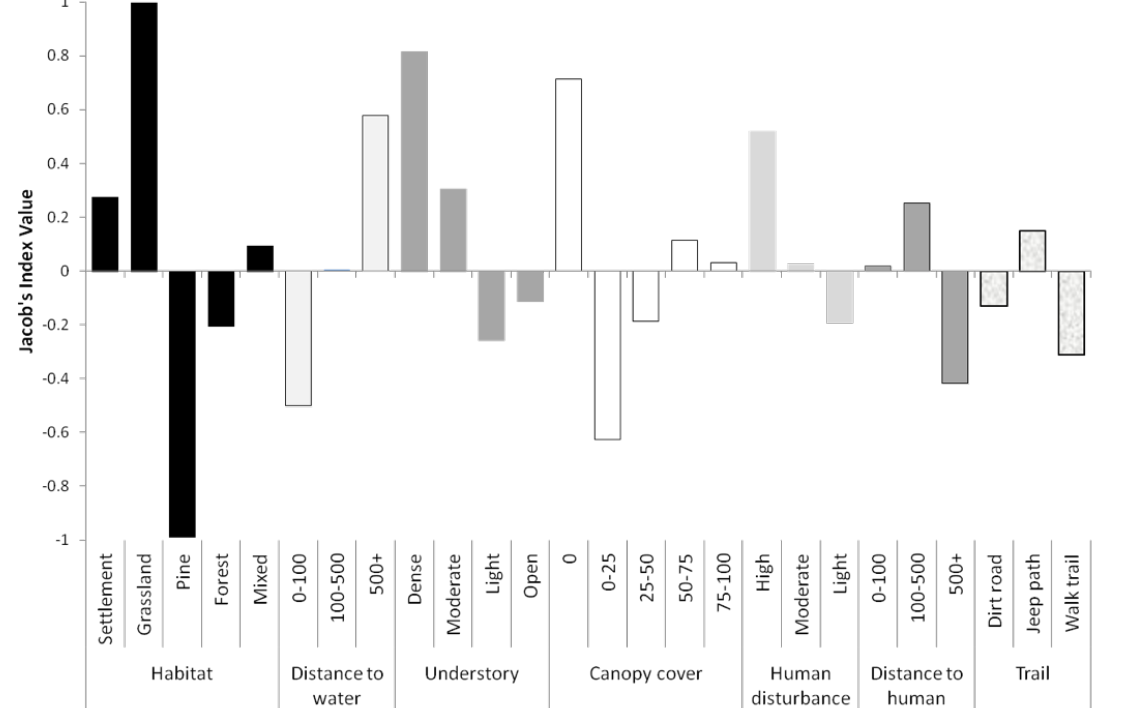
Figure 3a. Bar plots representing Jacob’s selectivity index values for leopards in Dunumadalawa forest reserve in the central hills, Sri Lanka. Habitat and landscape measures are based on comparison of locations used by leopards as detected by sign or observation (N=39) and a systematic random sample of available points (N=68). Values range from -1 which indicates maximum avoidance to 1 which indicates maximum selection. No selection is indicated by a value of